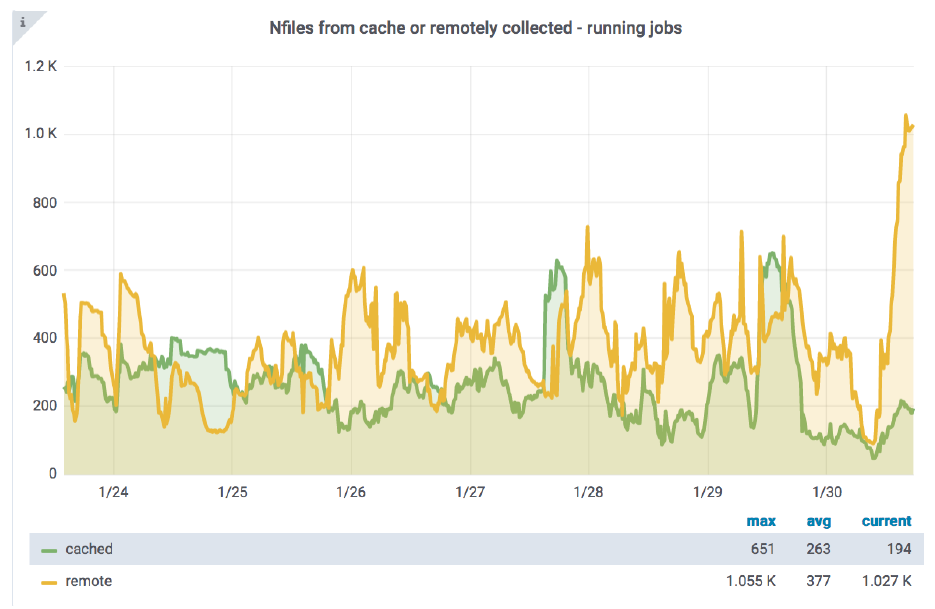
Figure 3: Number of files collected from ARC Cache or from remote storage over the course of 6